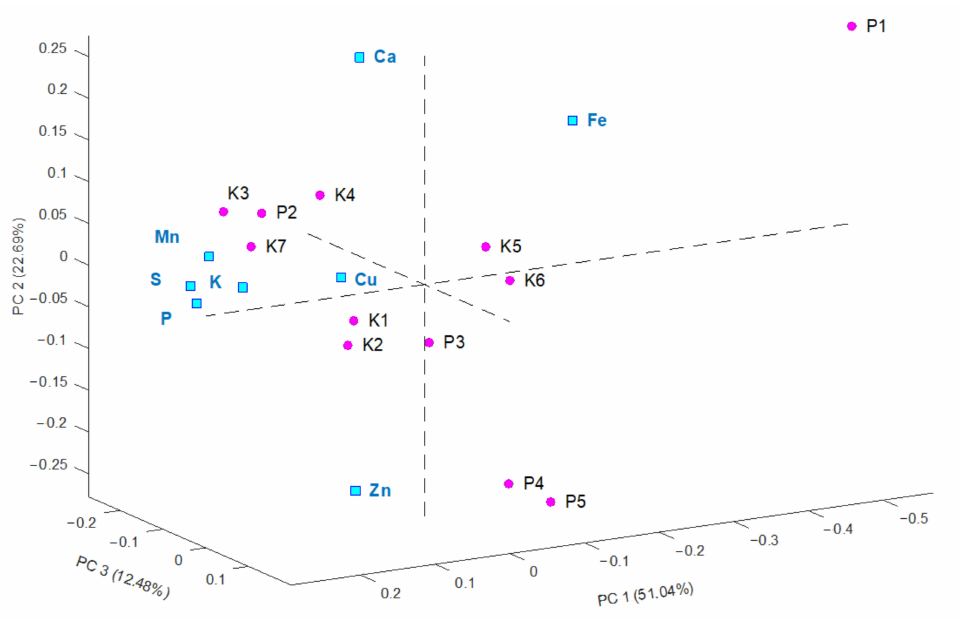
Figure 2. Biplot graph presenting the data from the ED-XRF analysis for bee pollen samples K1–K7 and P1–P5 (pink) and analyzed elements (blue).